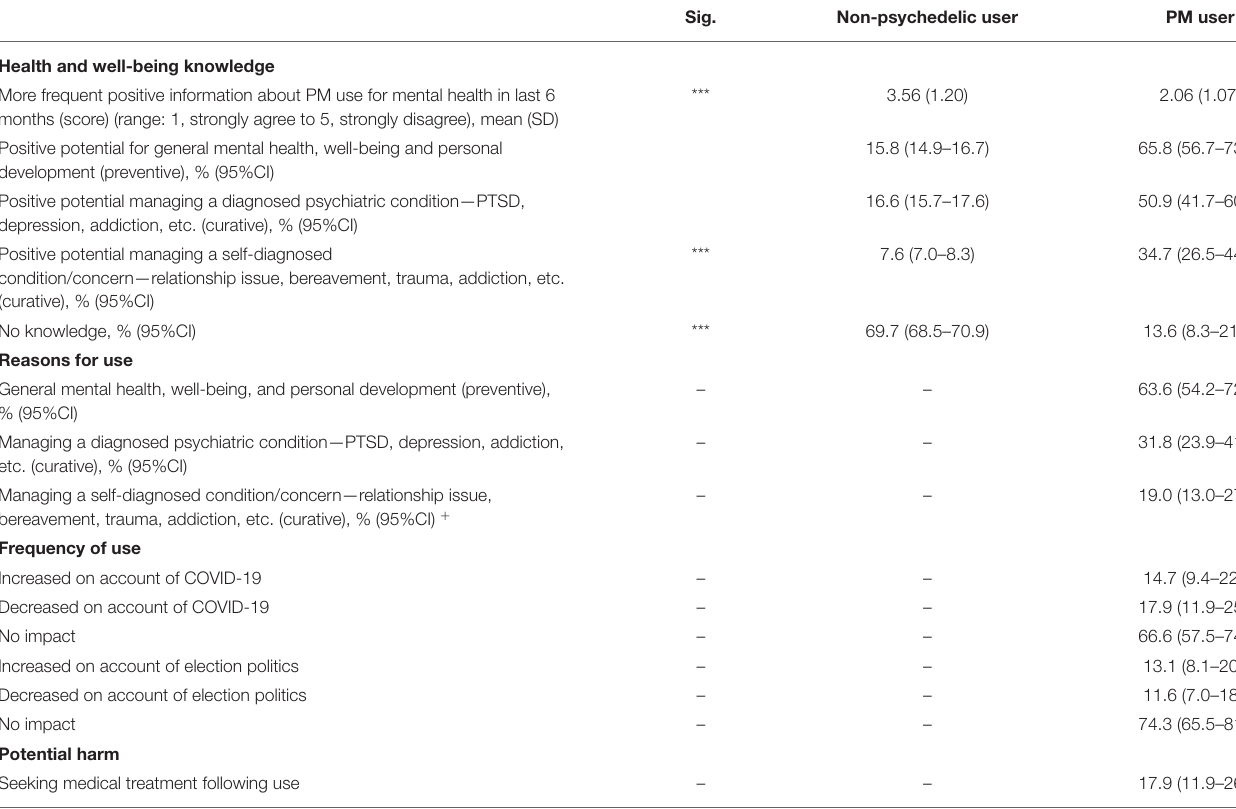
TABLE 3 | Non-psychedelic user and PM user, knowledge and use of PMs for health and well-being, US Adult population 2020/21 (weighted).